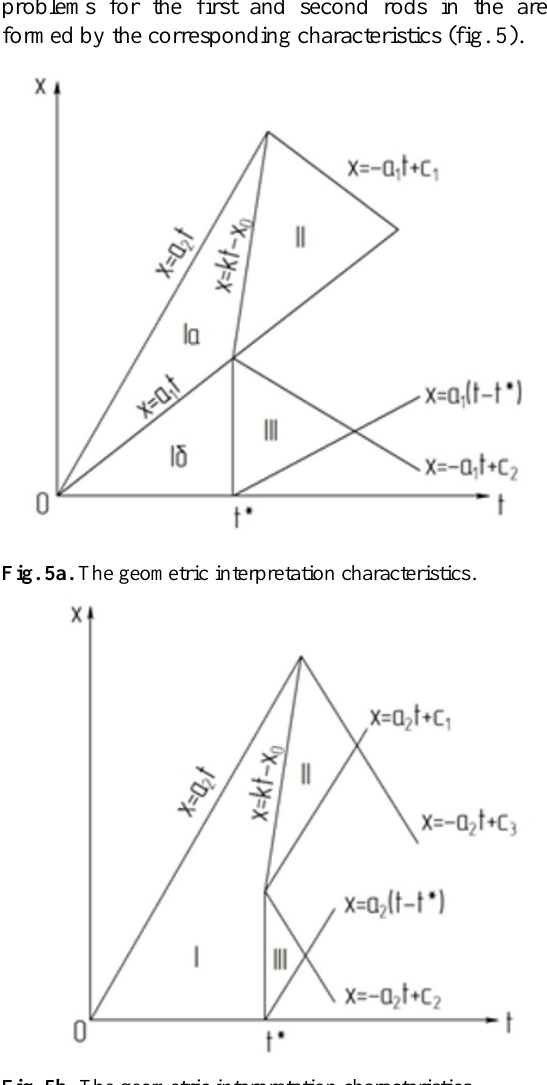
Fig. 5b. The geometric interpretation